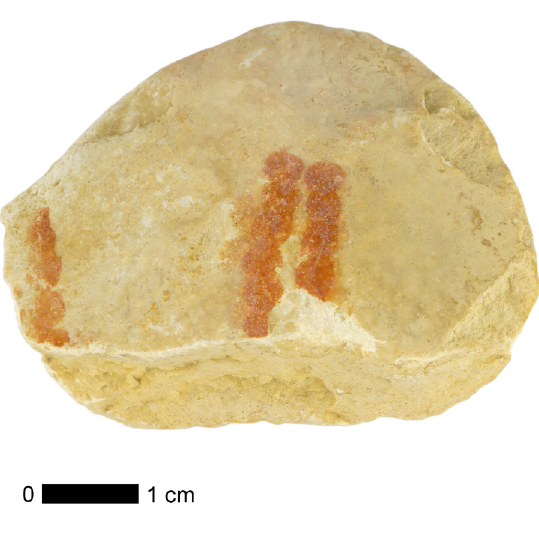
Figure 10. Hohle Fels, painted limestone, excavated 2013. Photo: M.